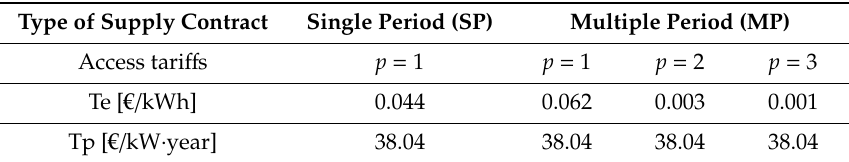
Table 2. Access tari ff coe ffi cients [42].